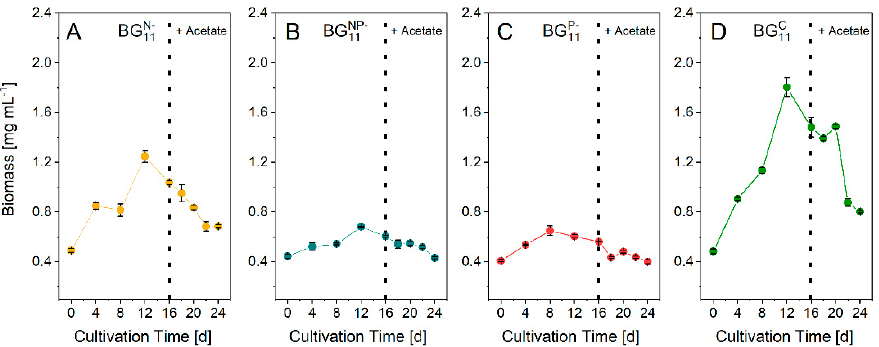
Figure 1. Biomass formation under N-deficiency (( A ), BG 11N − ), N- and P − deficiency (( B ), BG 11NP − ), P- deficiency (( C ), BG 11P − ), and without deficiency (( D ), control, BG 11C ). The dashed vertical line indicates the addition of 2 g L − 1 sodium acetate and the beginning of the mixotrophic stage. Data are the mean ± SD of three replicates.